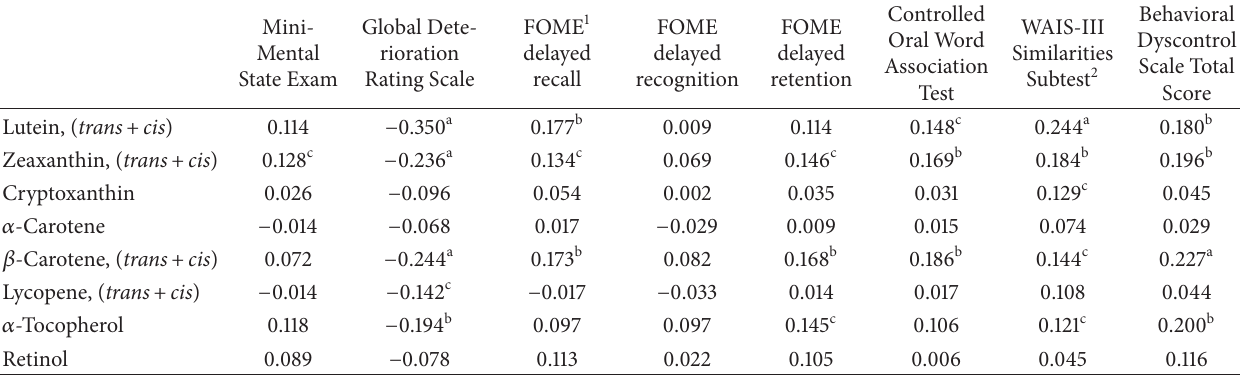
Table 3: Partial correlation coefficients between cognition indices and serum carotenoids, 𝛼 -tocopherol, and retinol in octogenarians